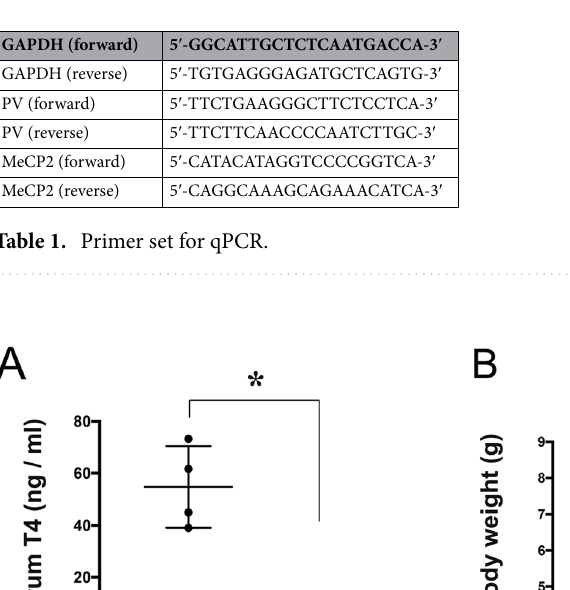
Fab fragments (1: 5000, catalogue No. 11093274910, Roche, Sigma-Aldrich Co.) and visualized with NBT/BCIP (Roche, Sigma-Aldrich Co.). Thionin stain. To investigate the developmental differences in cortical layers between normal and hypothy- roid mice, brain sections were stained with thionin, which detects Nissl bodies (i.e., rough-surface endoplasmic reticulum and polysome). The total area of cortical layers II–IV, which included the somatosensory, auditory, and visual cortices, was measured using ImageJ (NIH, USA). The region of interest was divided into 3 areas (ROI 1: − 0.70 to − 1.34 mm, ROI 2: − 1.34 to 1.82 mm, and ROI 3: − 1.82 to − 2.30 mm from the bregma) along the rostrocaudal axis, and the areas were compared between normal and hypothyroid animals. Relative quantitative PCR (qPCR).